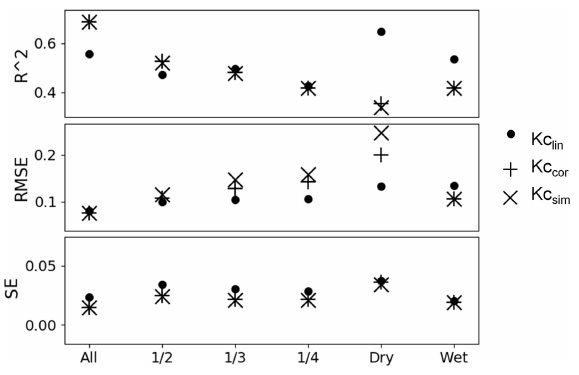
Figure 4. Performance indicators ( r 2 , RMSE, SE) for the three vari- ations of the model ( K c , lin , K c , cor , K c , sim ) as a function of the splitting strategy for determining the calibration/validation